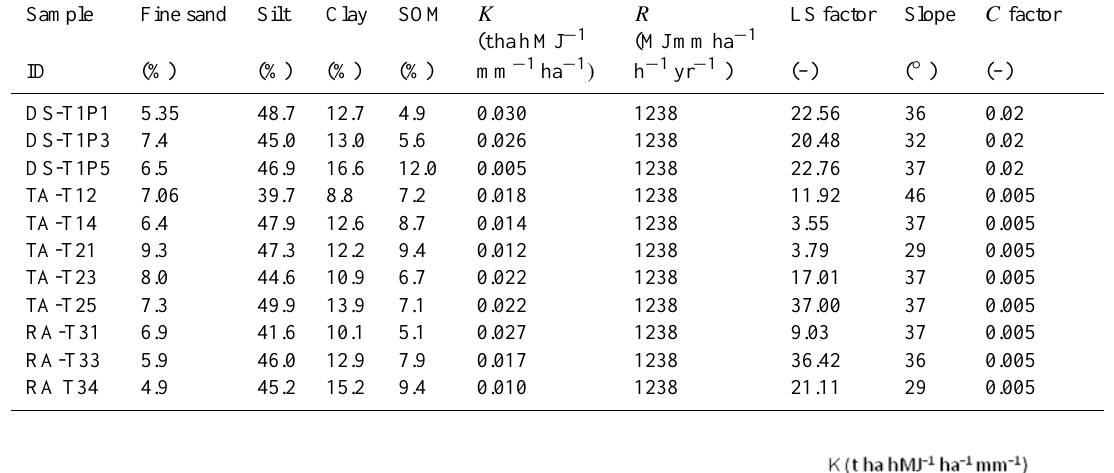
Table 1. Input data for the calculation of RUSLE factors, and RUSLE factors at sampled points. Textural classes and SOM content were used as input data for K calculation. DS: defense structures area; TA: track area; RA: release area. The considered soil depth was 10cm.